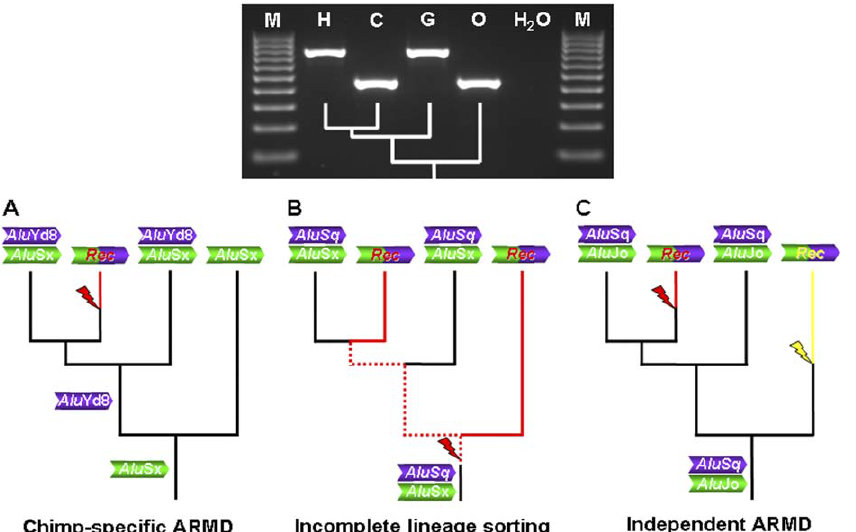
Figure 5. Incomplete Lineage Sorting and Parallel Independent ARMD Events The DNA template used in each reaction is listed on top of the gel chromatograph (M, 100-bp ladder; H, human; C, chimpanzee; G, gorilla; O, orangutan). The large and small sizes of PCR products indicate two Alu elements and one Alu element, respectively. The thunderbolts represent recombination events between two Alu elements, causing ARMDs. Possible scenarios that explain the observed chromatograph: (A) chimpanzee- specific ARMDs, (B) incomplete lineage sorting of an ARMD event, and (C) parallel independent ARMD events.